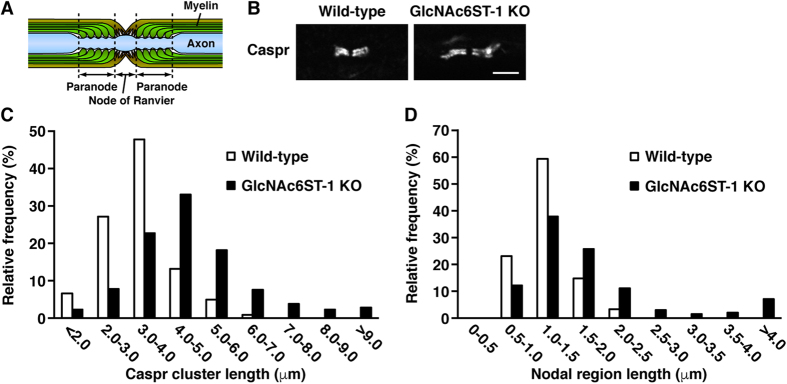
GlcNAc6ST-1 deficiency in mice causes abnormal myelination in the PNS.(A) The schematic drawing represents structural and functional domains in a longitudinal section of a myelinated axon around the node of Ranvier. (B) Longitudinal sections of sciatic nerves from young adult WT and GlcNAc6ST-1-KO mice were immunostained using antibodies against Caspr, a paranodal marker. Scale bar, 5 μm. (C) The Caspr-stained paranodal lengths of sciatic nerves from young adult WT (n = 122) and GlcNAc6ST-1-KO (n = 398) mice were measured. (D) The nodal gap lengths between paranodal Caspr clusters were measured in sciatic nerves from young adult WT (n = 61) and GlcNAc6ST-1-KO (n = 199) mice.